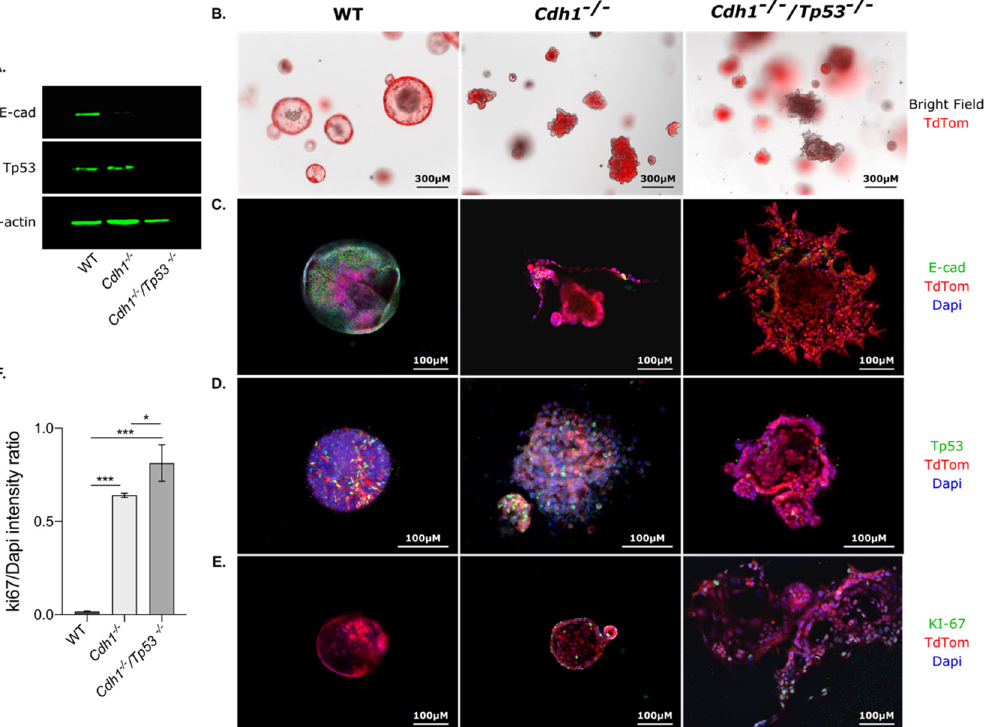
Figure 4. Cdh1 and Tp53 inactivation disrupt gastric organoids morphology. Organoids were generated using inducible Cre-lox mice. WT organoids express an inducible tdTomato fluorescence following Cre induction. Cdh1 − / − organoids exhibit tdTomato expression and Cdh1 deletion while Cdh1 − / − / Tp53 − / − organoids exhibit tdTomato expression associated with Cdh1 and Tp53 deletion when induced with endoxifen. Organoids were induced at day 1 post-seeding followed by Western blot and immunofluorescences at day 6. ( A ) Western blot was performed on protein extracted from WT, Cdh1 − / − and Cdh1 − / − / Tp53 − / − organoids. E-cadherin staining was observed at 110 kDa, Tp53 at 53 kDa and β -actin at 45 kDa. ( B ) Bright field and tdTomato expression were assessed after 5 days of induc- tion with endoxifen. WT organoids maintained a circular morphology while both Cdh1 − / − and Cdh1 − / − / Tp53 − / − organoids displayed a loss of circularity with the presence of evaginations. ( C ) Im- munofluorescence on WT, Cdh1 − / − and Cdh1 − / − / Tp53 − / − organoids with E-cadherin stained in green, tdTomato in red and DAPI in blue for nuclear staining. The absence of E-cadherin was confirmed in both Cdh1 − / − and Cdh1 − / − / Tp53 − / − organoids. ( D ) Immunofluorescence with Tp53 staining in green. Tp53 was present in the WT and Cdh1 − / − organoids and absent in the Cdh1 − / − / Tp53 − / − organoids. ( E ) KI-67 to label for proliferation was performed at day 6 post-seeding. KI-67 (in green) was absent in the WT organoids at day 6 indicating an arrest of proliferation whereas Cdh1 − / − and Cdh1 − / − / Tp53 − / − organoids still presented cells in proliferation. ( F ) The intensity ratio between KI-67 and DAPI stain- ing was measured every 10 microns on whole WT, Cdh1 − / − and Cdh1 − / − / Tp53 − / − organoids by confocal microscopy. Statistically significant results are labeled as * p < 0.05 and *** p < 0.001. Immunofluorescence on WT, Cdh1 − / − and Cdh1 − / − / Tp53 − / − organoids with E-cadherin antibodies showed that, as expected, E-cadherin was strongly expressed in WT organoids and largely absent from the Cdh1 − / − and Cdh1 − / − / Tp53 − / − organoids (Figure 4C). Immunoflu- orescence also detected Tp53 expression in a population of cells in the WT and Cdh1 − / − organoids and confirmed its near complete loss from the Cdh1 − / − / Tp53 − / − organoids (Figure 4D). Proliferation was also assessed at day 4 by KI-67 antibody staining and showed pro- liferation in WT, Cdh1 − / − and Cdh1 − / − / Tp53 − / − organoids (data not shown). However, at day 6, only Cdh1 − / − and Cdh1 − / − / Tp53 − / − organoids contained proliferating cells (Figure 4E). Moreover, the intensity ratio between KI-67 and DAPI nuclear staining was measured every 10 microns on the whole organoids and then averaged (Figure 4F). The ratio was significantly higher in Cdh1 − / − and Cdh1 − / − / Tp53 − / − organoids compared to WT. These results are consistent with previous studies that have shown that inactivation of E-cadherin and